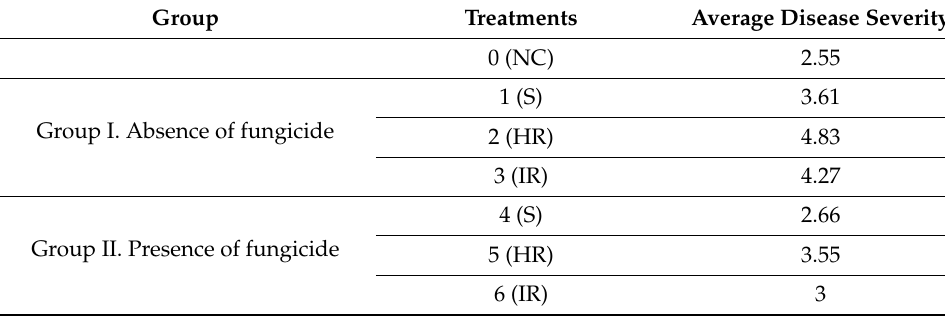
Table 2. Watermelon seedling treatments with average disease severity.